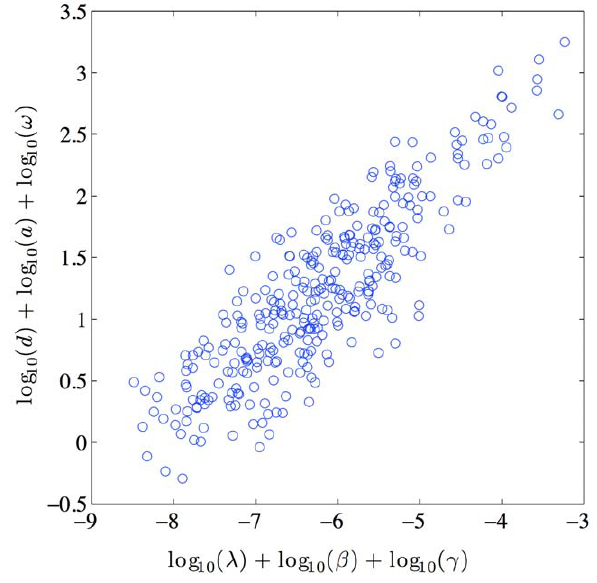
Figure 3. The marginal posterior distribution of each parameter for ten different patients.